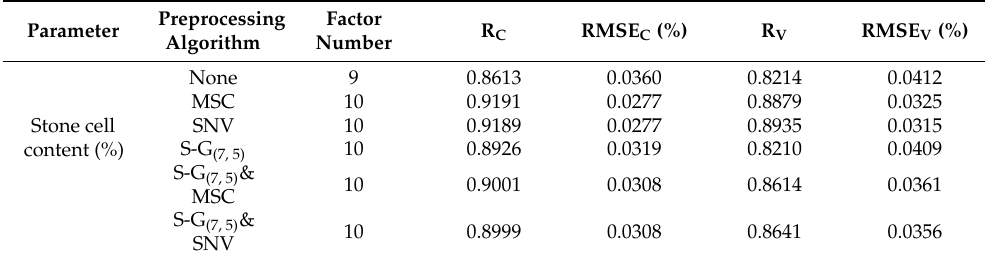
Table 3. Evaluation of PLSR based on different spectral preprocessing algorithms.